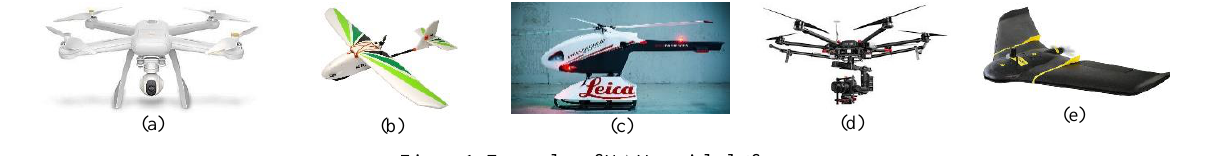
Figure 1. Examples of UAV aerial